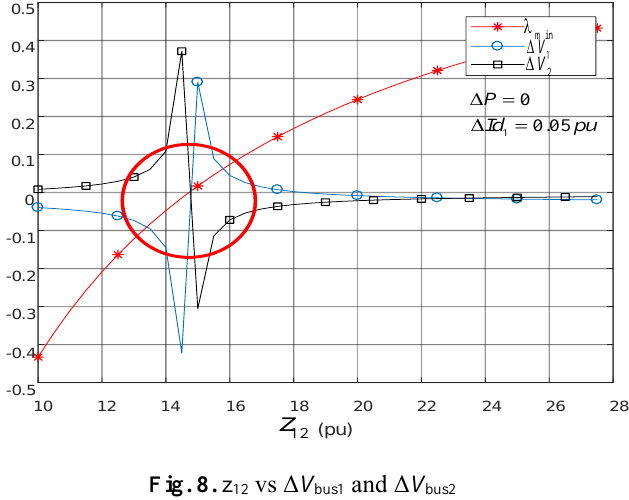
Fig. 8. z 12 vs Δ V bus1 and Δ V bus2